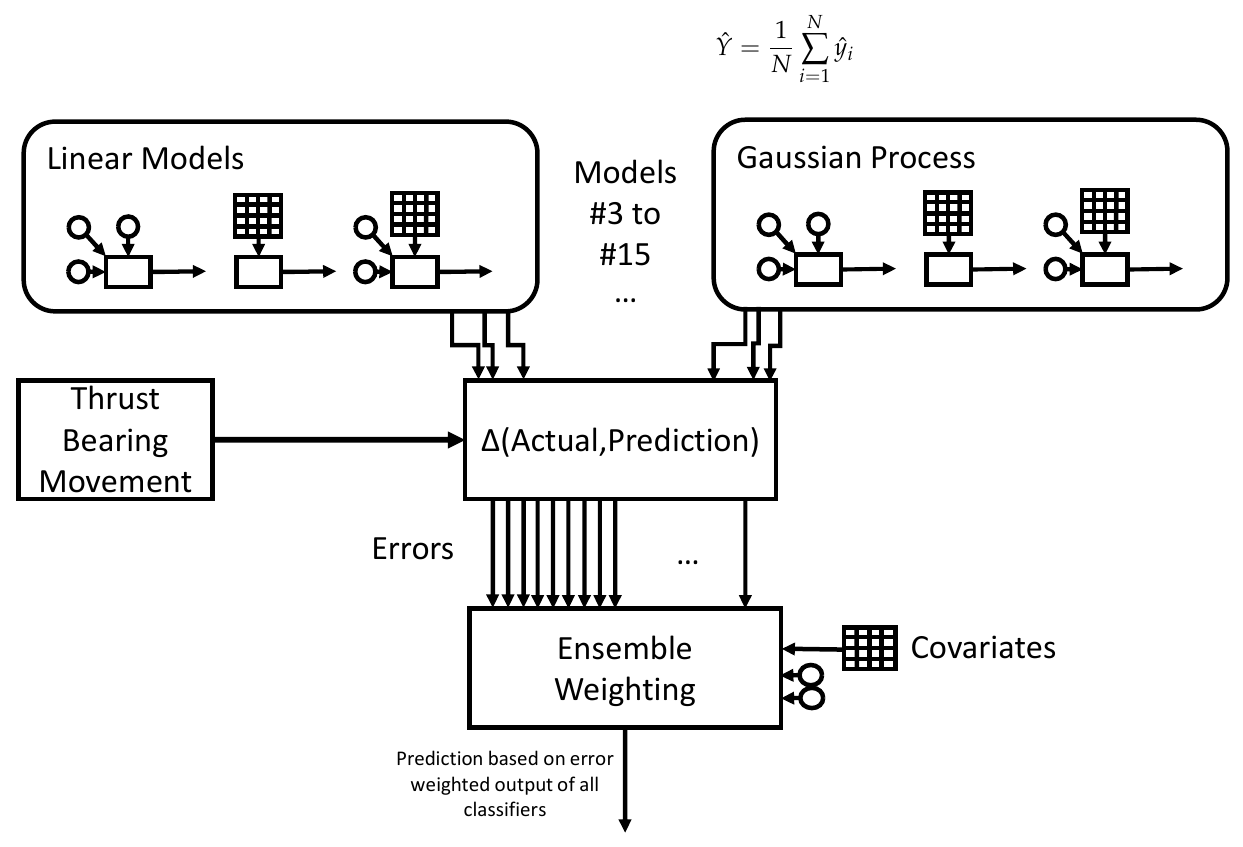
Figure 9. Data pipeline through the ensemble predictive model. Eighteen candidate models are drawn from six predictive models and three sets of covariates.